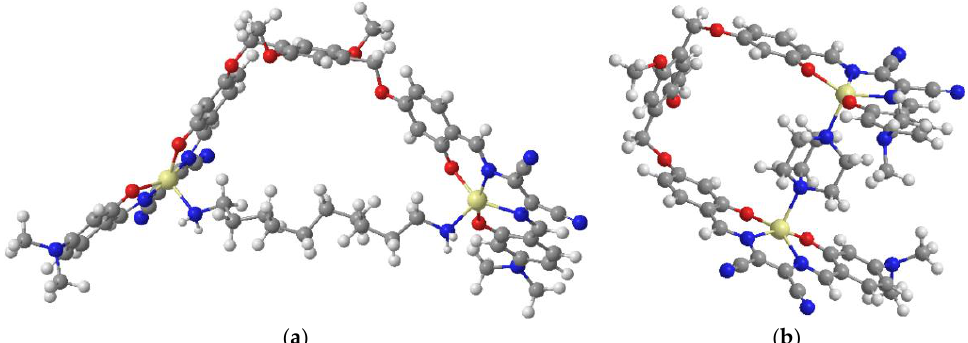
Figure 5. ( a ) Modeling (PM3, using the HyperChem Software (8.0)) of the 1 ·diaminodecane adduct and ( b ) modeling of the 1·DABCO adduct.